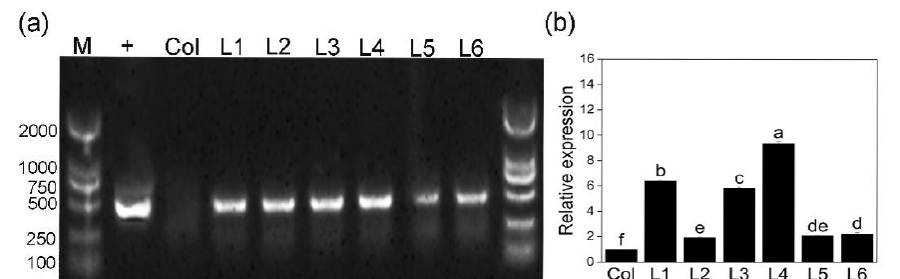
Fig. 1: Identification of transgenic Arabidopsis thaliana overexpressing MdAGO4.1. (a) Identification of MdAGO4.1 transgenic lines by PCR. MDNA marker DL2000; +, positive control; (b) Identification of MdAGO4.1 transgenic A. thaliana lines by qRT-PCR.